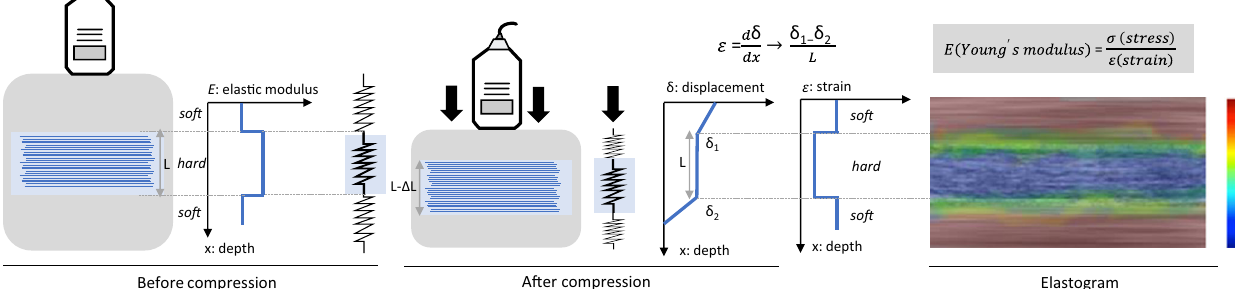
Fig. 1 Basic physical principle of compression elastography (CE). The operator exerts compression on the tissue, generating a displacement ( δ ) that can be estimated by comparing the structure at rest and under compression. The strain ( ε ) is the ratio difference in displacement